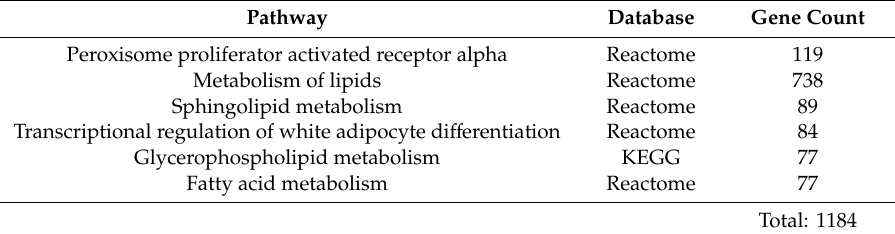
Table 4. Lipid metabolism-related pathways in the Molecular Signature Database.